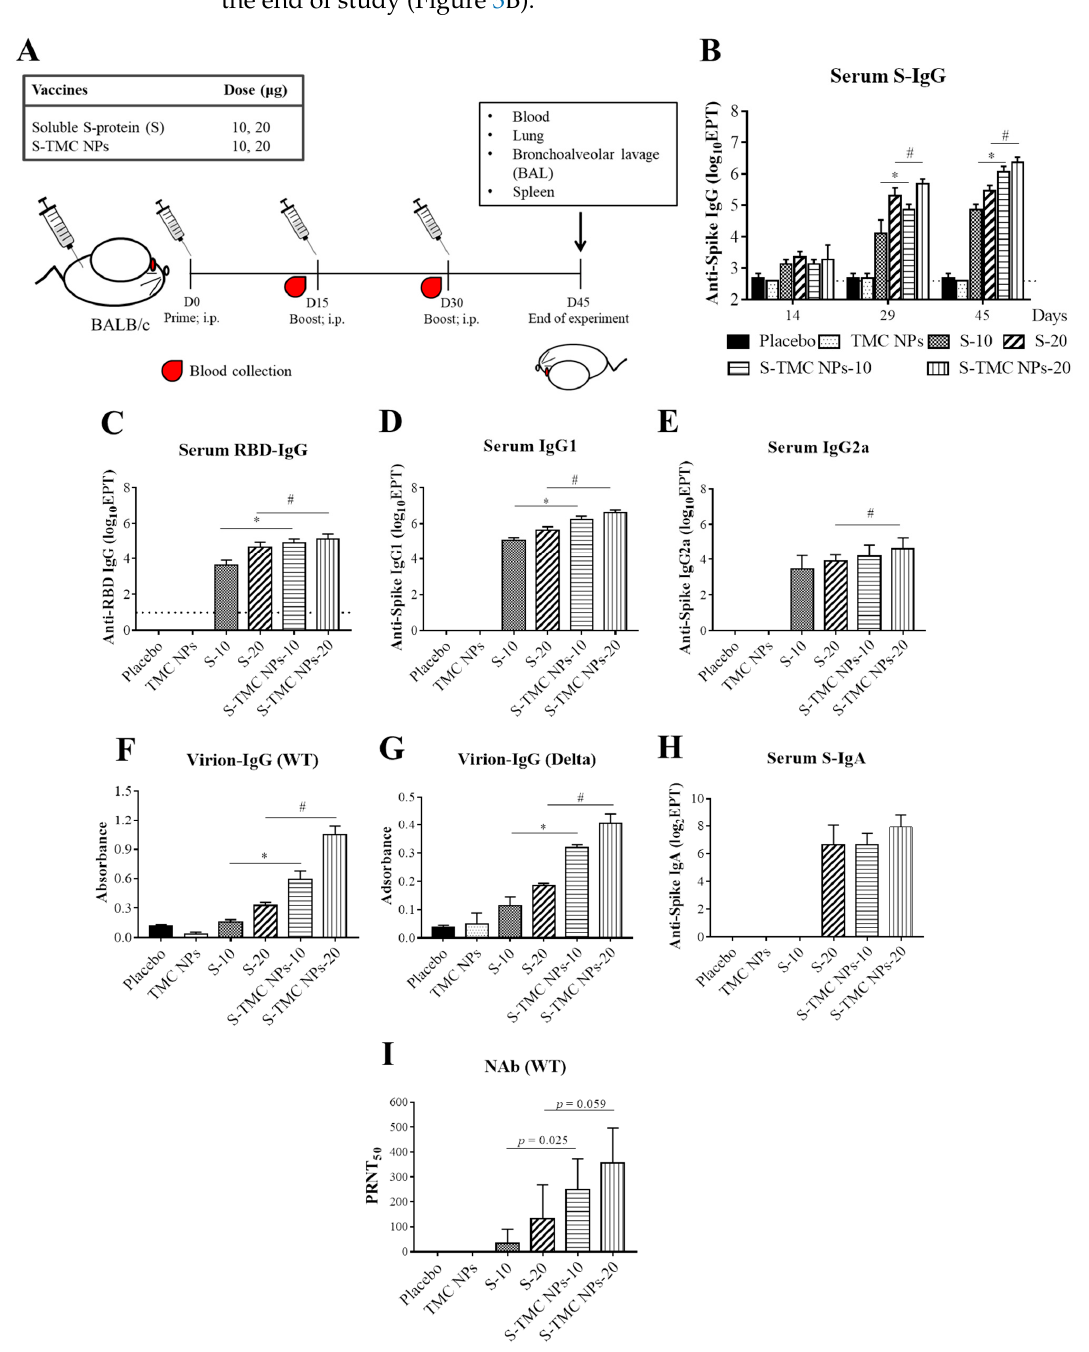
Figure 3. Systemic humoral responses to soluble S-protein or S-TMC NPs. Mice were immunized intraperitoneally with three doses (2 weeks apart) of soluble S-protein (S) or S-TMC NPs (10 or 20 μ g/dose). By Day 45 after immunization, samples from immunized mice, including blood, lungs, BALs and spleens, were harvested ( A ). Sera of immunized mice on Days 14, 29 and 45 were subjected to measurement of S-specific IgG by indirect ELISA ( B ). Sera on Day 45 were analyzed for RBD-specific IgG ( C ), S-specific IgG1 ( D ) and IgG2a ( E ) antibody ELISA assays. The levels of SARS-CoV-2-binding antibodies (Virion-IgG) in sera at a dilution of 1:100 were determined by capture ELISA against wild-type (WT) ( F ) and Delta variant viruses ( G ). IgA titers specific to purified S-protein were determined by indirect ELISA ( H ). The titers of serum neutralizing antibodies against SARS-CoV-2 were quantified by PRNT ( I ). Data are presented as means ± SD ( n = 4); * and # indicate a significant difference between soluble S-protein and S-TMC NPs at 10 and 20 µ g/dose, respectively ( p < 0.05). Dotted line indicates the limit of detection (LOD) of the